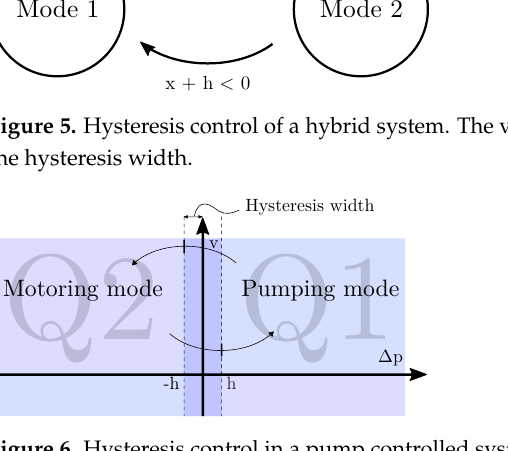
Figure 6. Hysteresis control in a pump controlled system where the switch is defined by the pressure difference ∆ p and the hysteresis width h